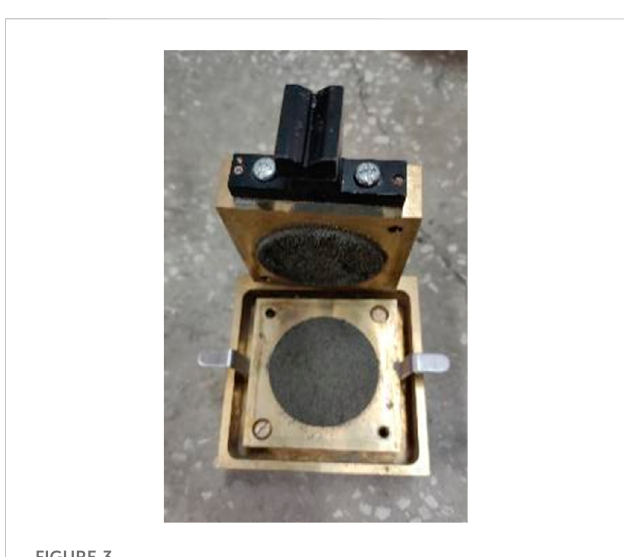
FIGURE 3 Shear plane after disassembly by the direct shear